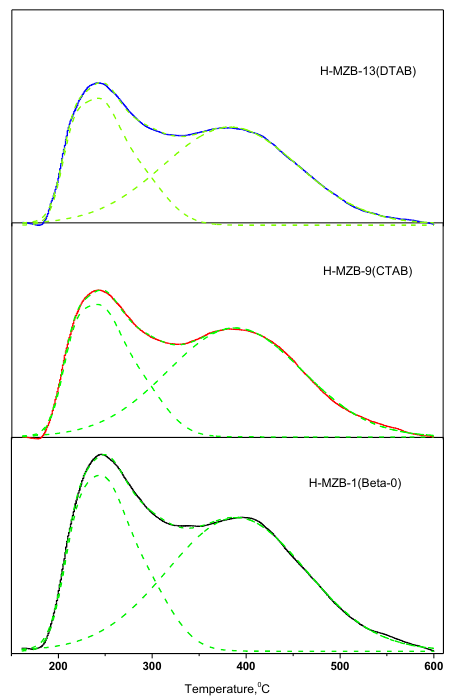
Figure 4. NH 3 -TPD curves of microzeolite Beta and hierarchical zeolite Betas.